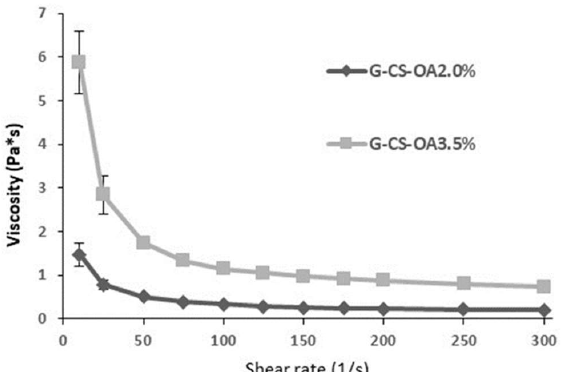
Figure 3. Viscosity curves of the emulsions based on CS-OA-2% and CS-OA-3.5% ( w / w ) (mean ± S.D., n = 3).